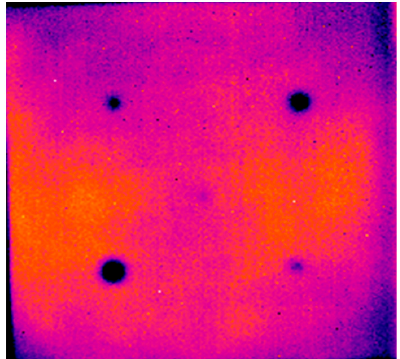
Figure 7. Fibers misalignment in a carbon/epoxy laminate; phase image taken with SC6000 camera.